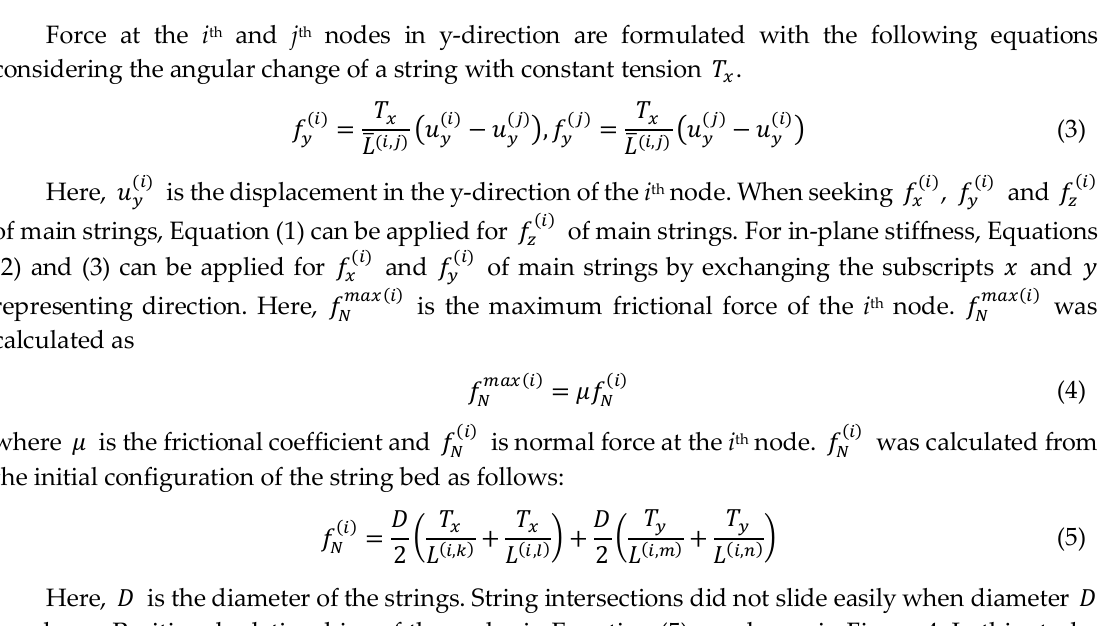
Figure 3. Deformation of string element with plane direction of string bed (Elements for main